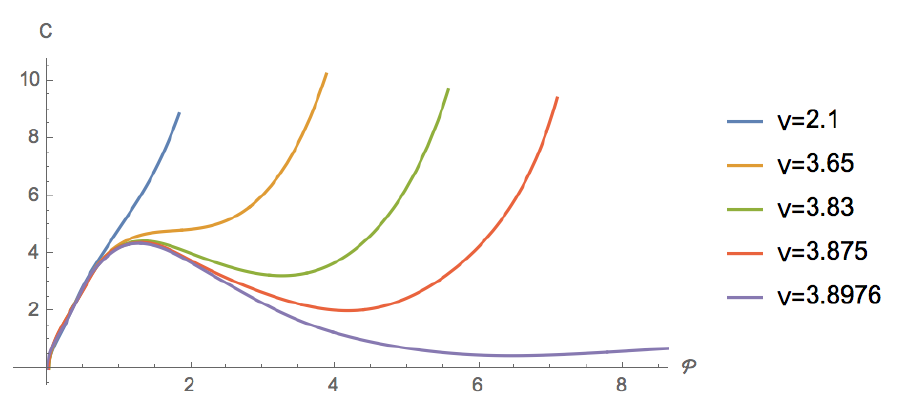
Figure 5 . Deformed hyperbolic black holes can become black globules. The circumference of the (cid:30) circles on the horizon is shown as a function of proper distance P from the axis for (cid:22) = 3 : 8 and various (cid:23) , approaching the border with D2 at (cid:23) (cid:24) 3 : 899. In this speci(cid:12)c example, the bottom three curves (green, red and purple lines) correspond to black globules.